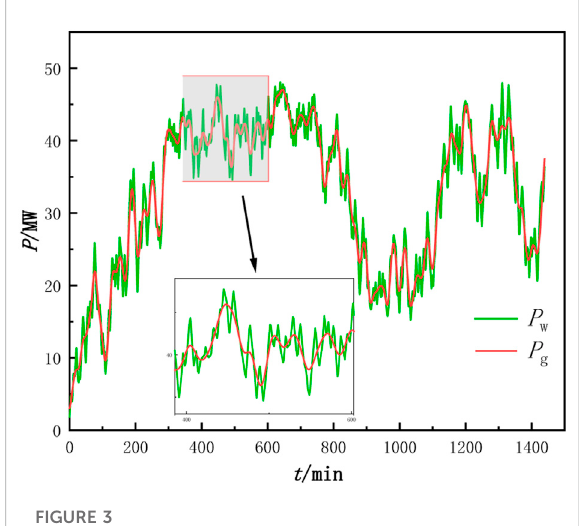
FIGURE 3 Raw wind power and grid-connected